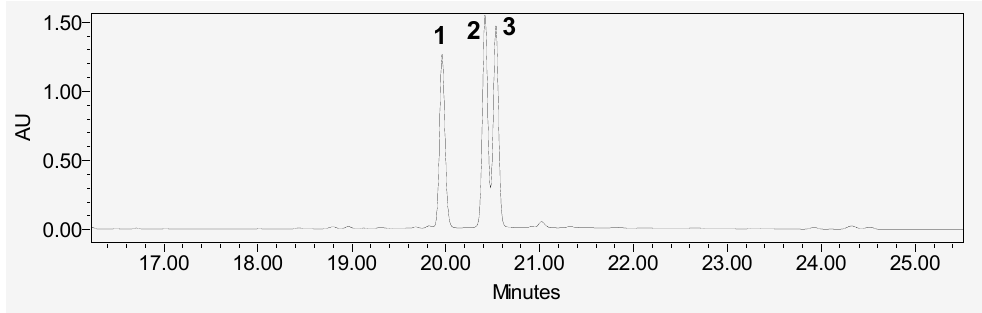
Figure 4. HPLC chromatogram of fraction A. Peaks 1, 2, and 3 referred to compound 1 , 2 , and 3 , respectively.